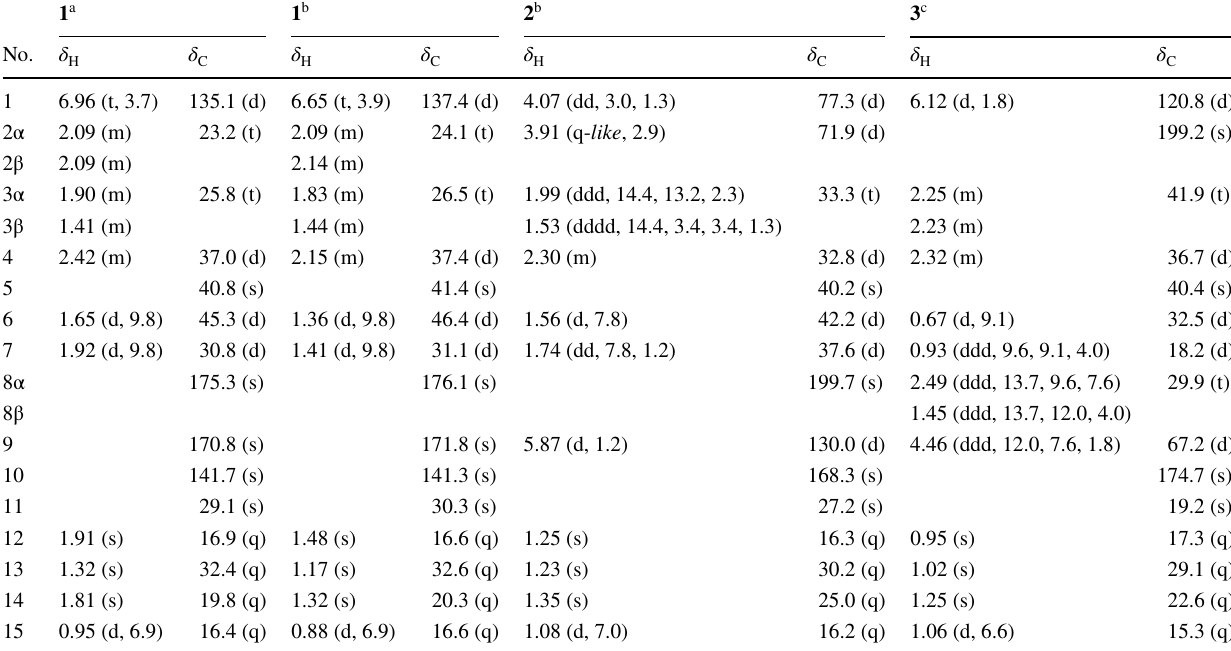
Table 1 1 H and 13 C NMR spectroscopic data of compounds 1 –